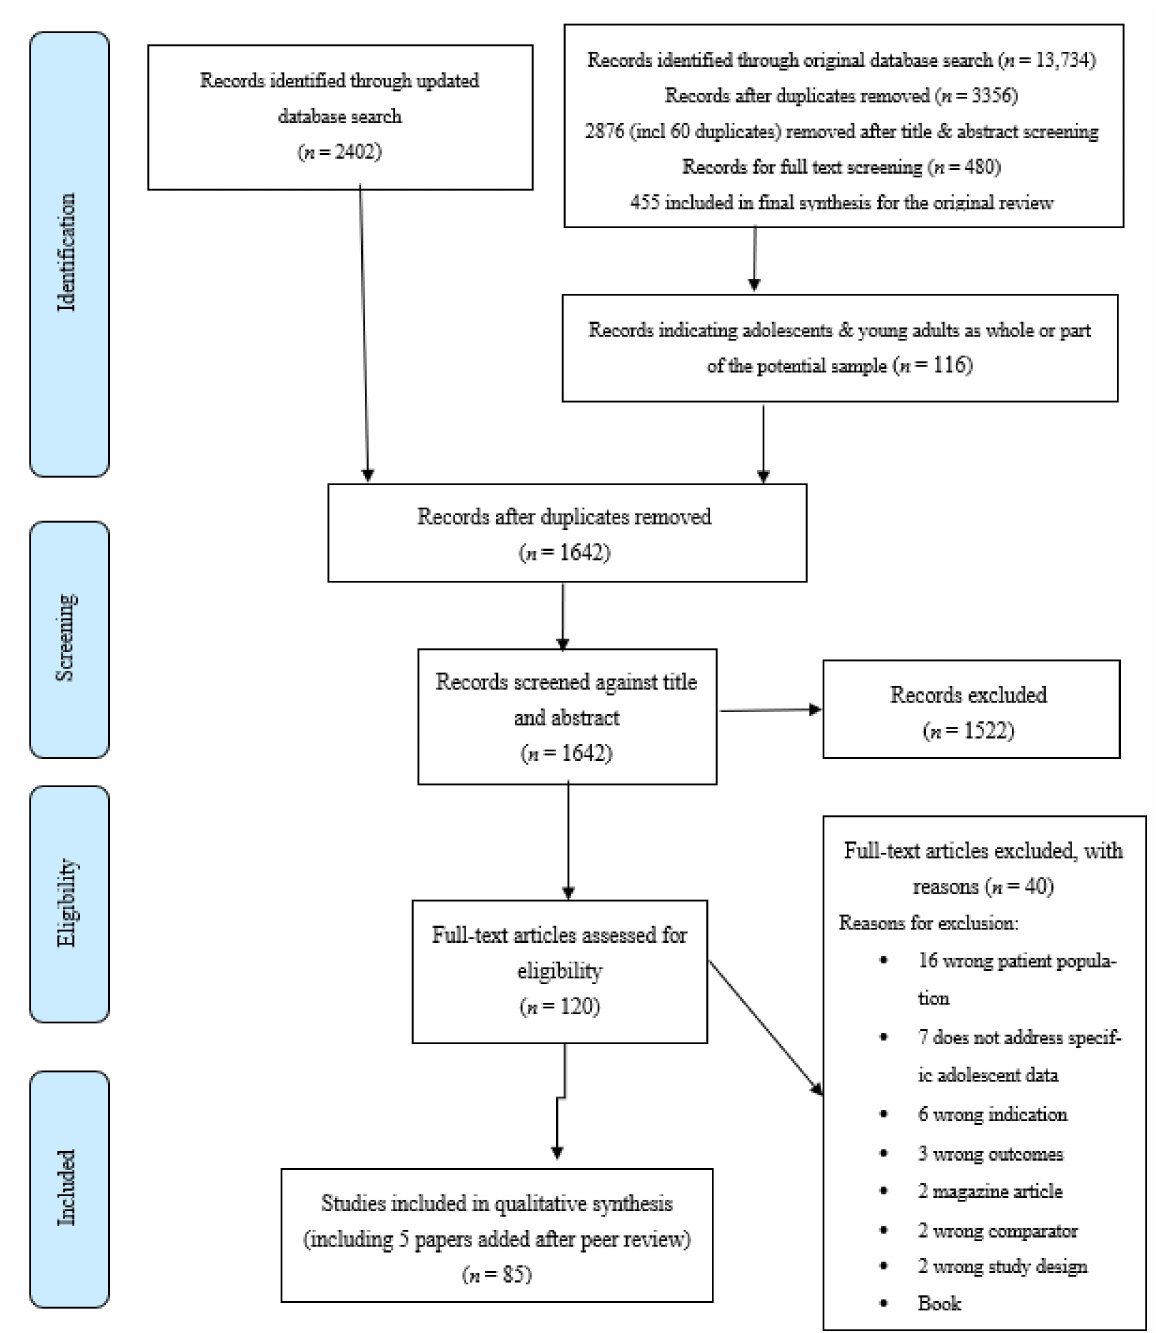
Figure 1. PRISMA